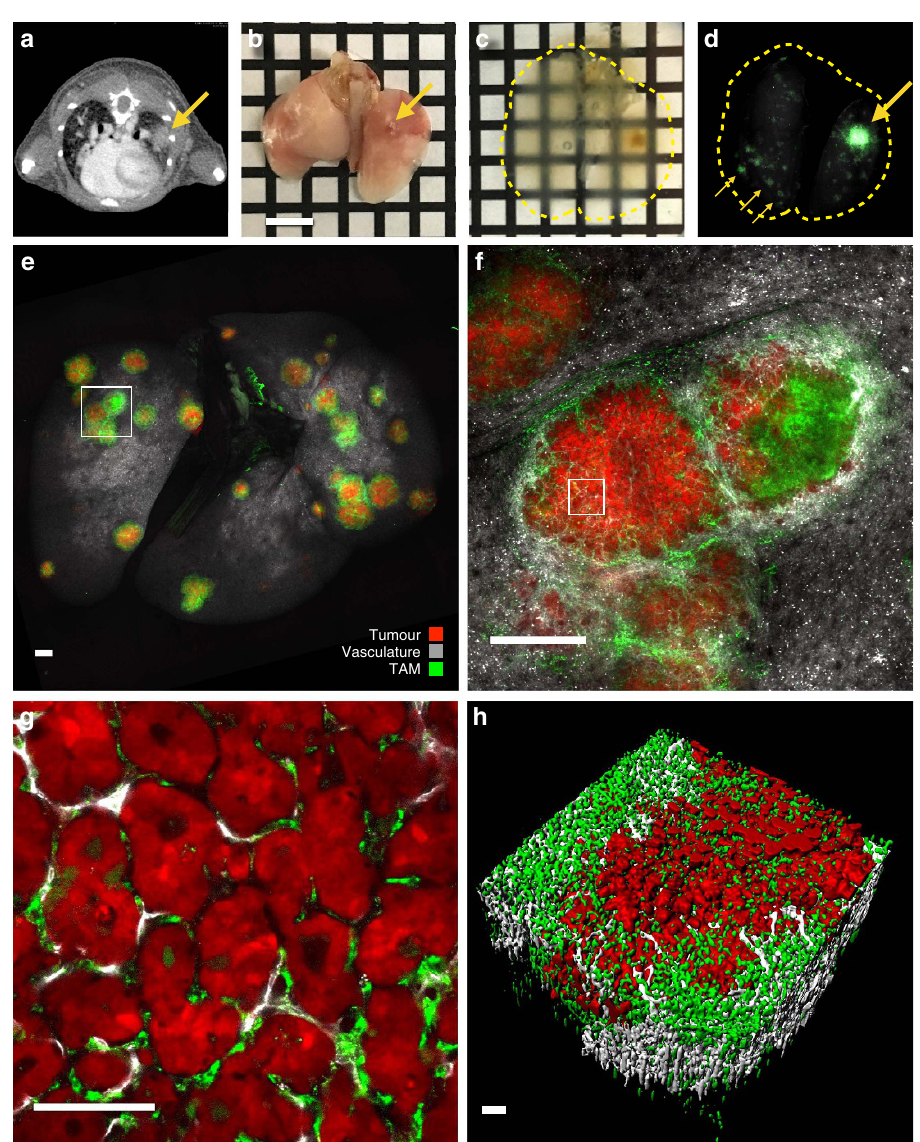
Figure 1 | Clearing of lung tissue allows visualization of tumour burden and other biologically relevant features. ( a ) CT scan of KP-tumour-bearing mouse and identification of large lung tumour (big arrow). ( b – d ) Process of clearing and imaging lungs and identification of small tumours (small arrows). ( e ) Wide-field image of whole lung from KP tumour-bearing animal. ( f ) (cid:2) 4 slice of a tumour from box in e . ( g ) (cid:2) 20-magnification imaging slice of a single tumour from box in f . ( h ) Computational 3D-rendering of a whole-lung tumour nodule. Scale bars, 5mm ( b ); 1,000 m m ( e , f ); 100 m m ( g , h ).